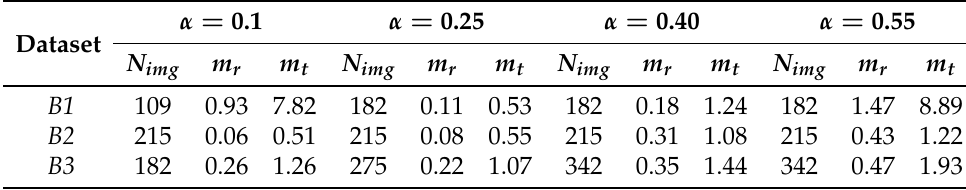
Table 6. Numerical comparisons of seed reconstruction results from different values of α . N img is the number of orientated images in the final reconstruction results. m r is the mean rotation error in degrees and m t is the mean translation error in ground-truth units × 10 − 2